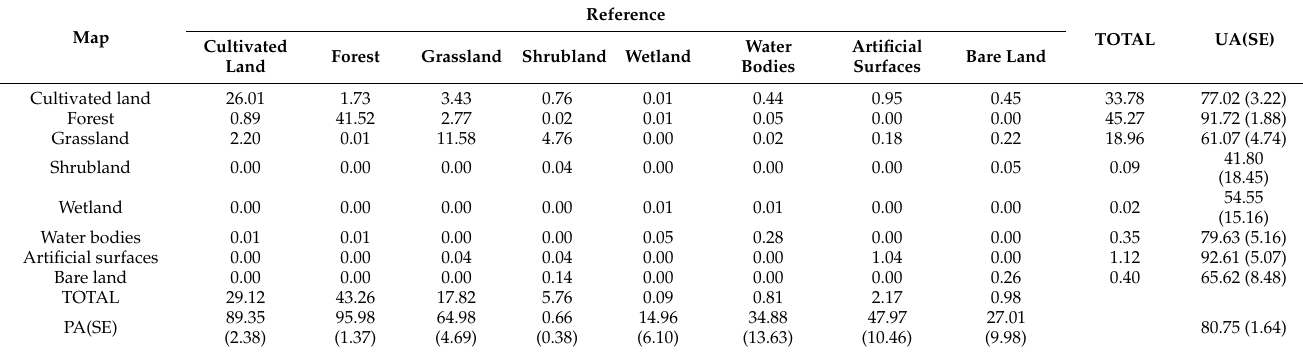
Table A12. Error matrix of fused product 2010 using consensus-based method.